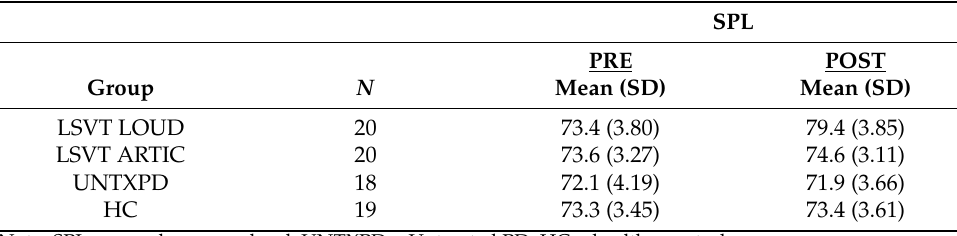
Table 3. Descriptive statistics for SPL (dB at 30cm) pre-treatment and 1 month post-treatment by